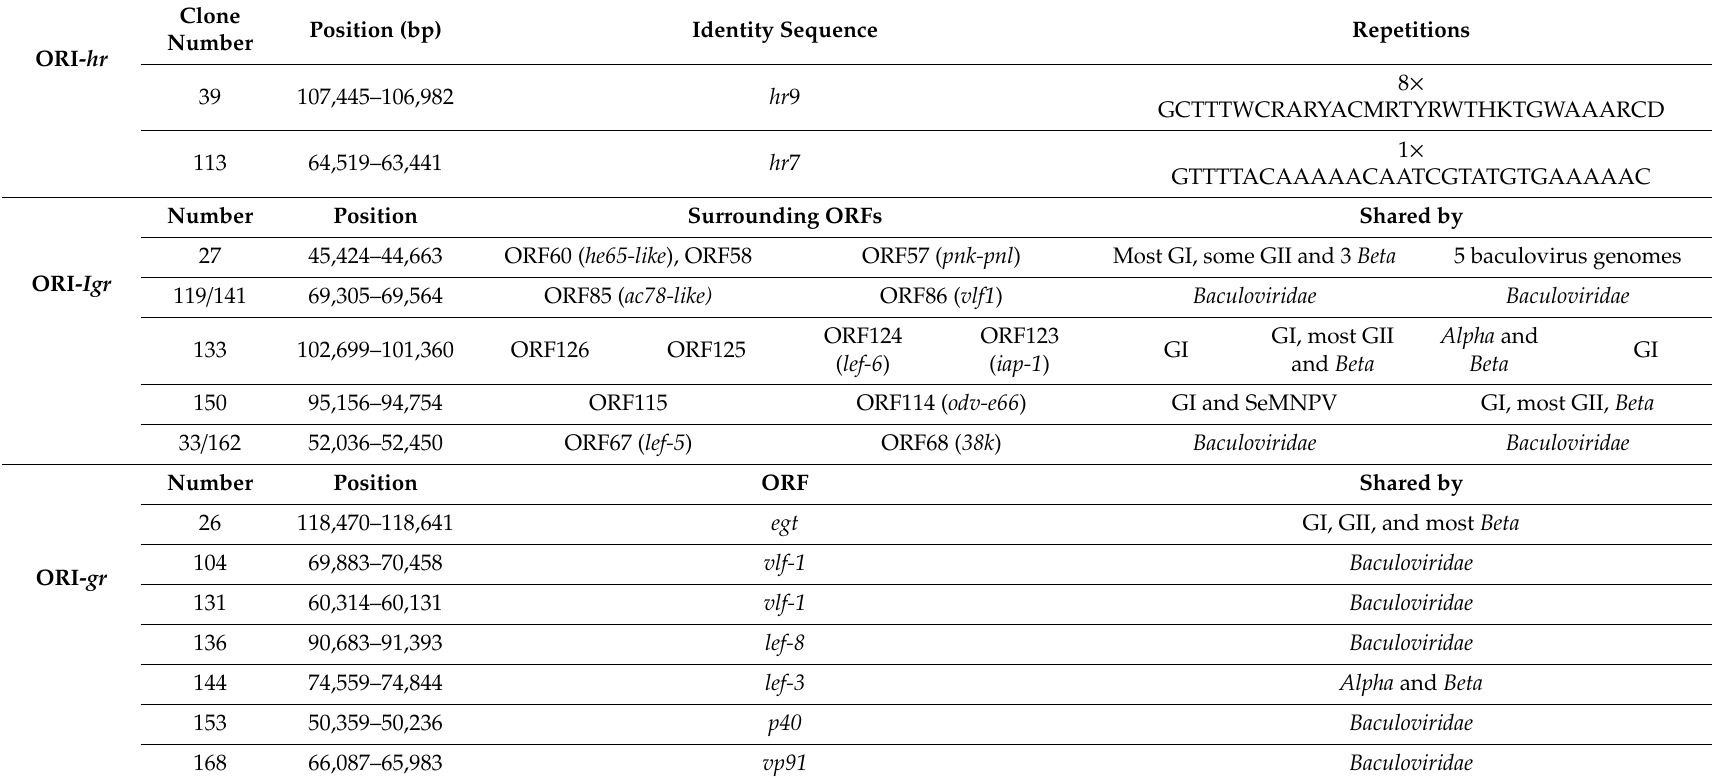
Table 1. Sequences containing ORIs of